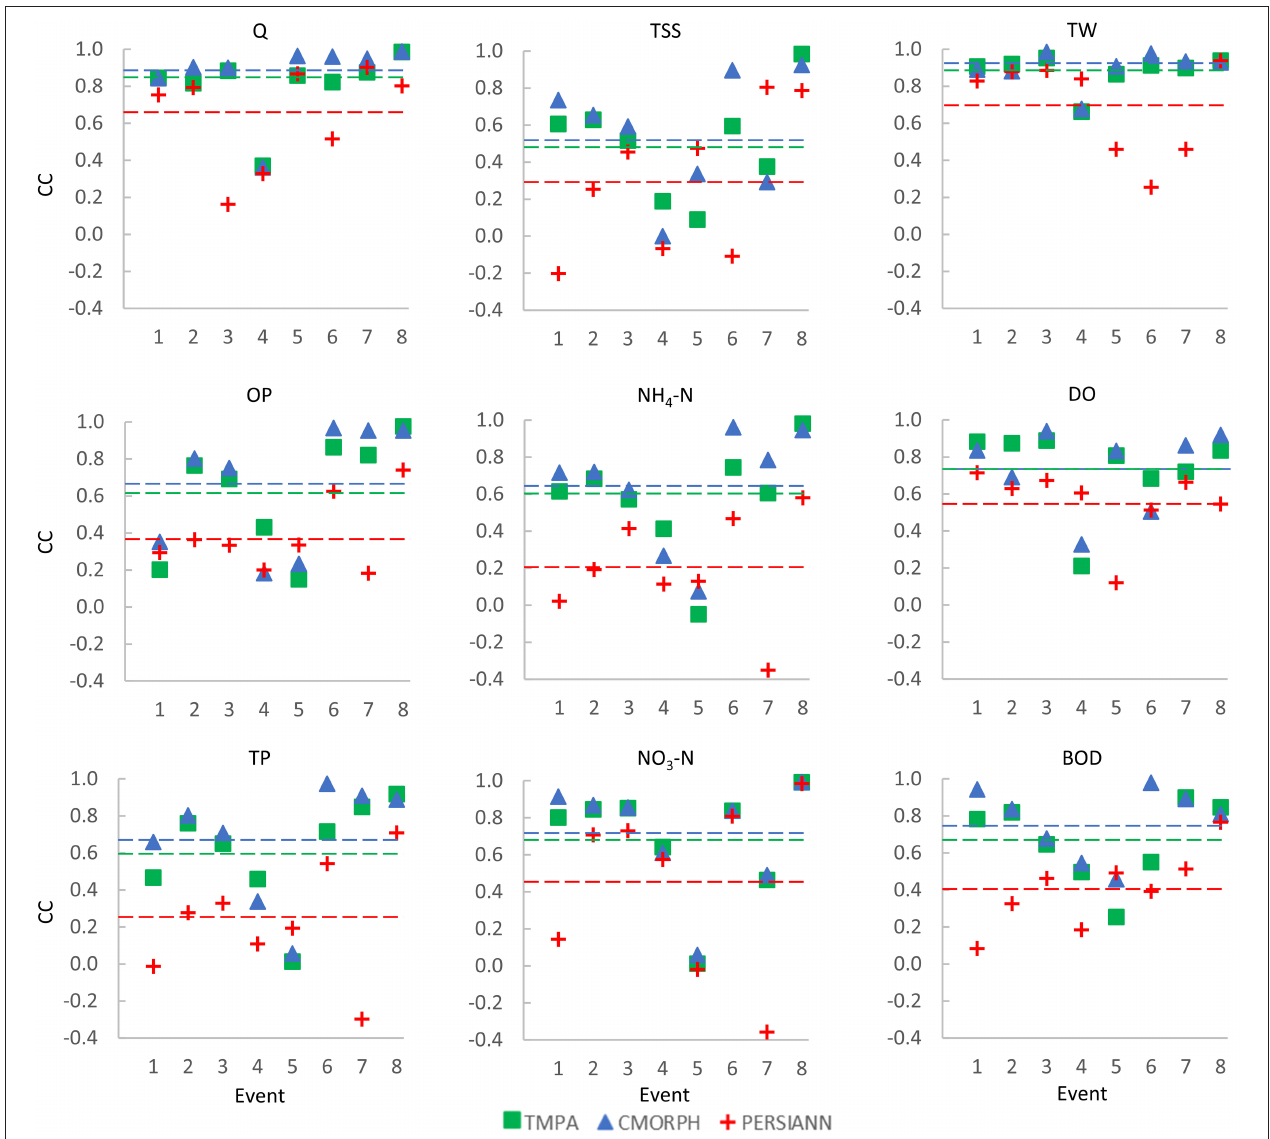
FIGURE 9 | Correlation coefficients of streamflow and water quality indicators between gauge-simulated and SPP-simulated output for TMPA, CMORPH, and PERSIANN for six evaluation points. The mean indicator value across all eight events is represented by a dashed line corresponding to TMPA, CMORPH, and PERSIANN in green, blue, and red,